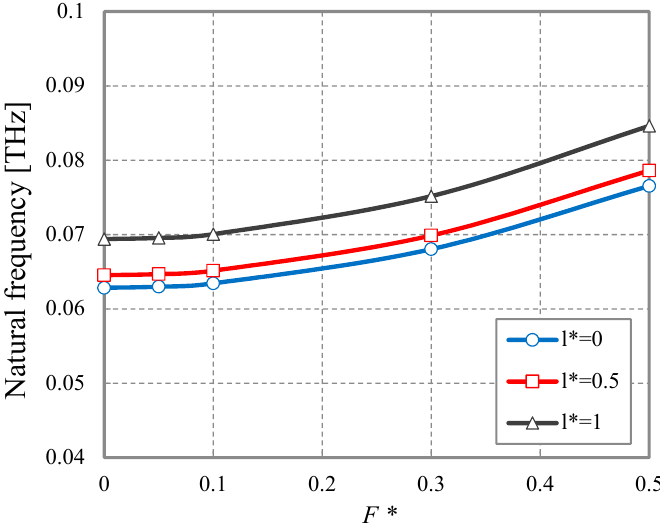
∗ . µ = 1.41 nm 2 , g = 2 Ns/m 2 ,